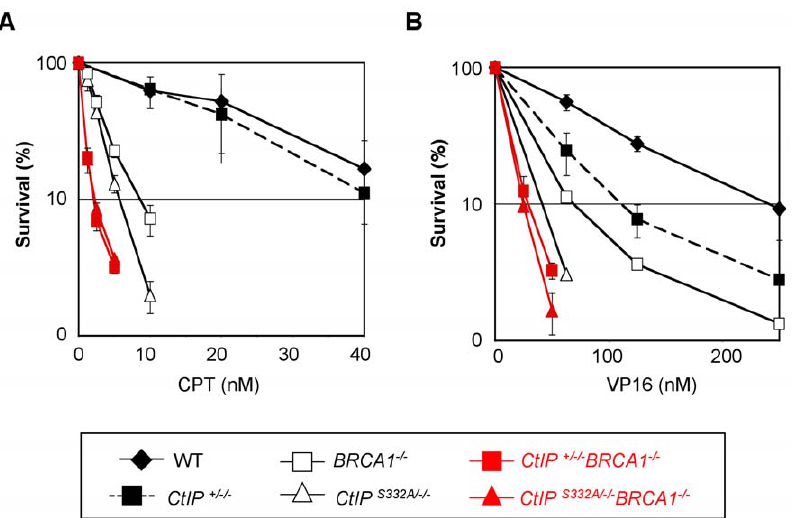
Figure 6. Epistasis analysis of BRCA1 and CtIP in cellular tolerance to topoisomerase inhibitors. Cellular survival of each genotype was assessed by measuring the amount of ATP in cell lysates after 48-h exposure to CPT (A) or VP16 (B). The survival curves for the CtIP S332A/ 2 / 2 BRCA1 2 / 2 cells and their control CtIP + / 2 / 2 BRCA1 2 / 2 cells are depicted in red. At least five independent experiments were performed with triplicate samples, and the representative results are shown. The error bars indicate